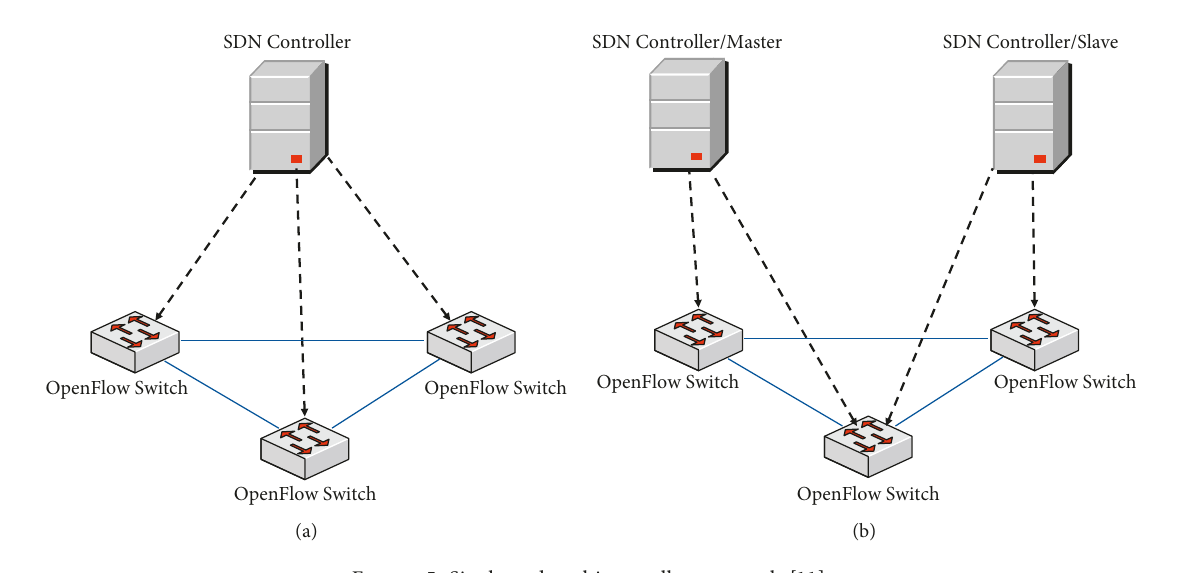
Figure 5: Single and multicontroller approach [11].